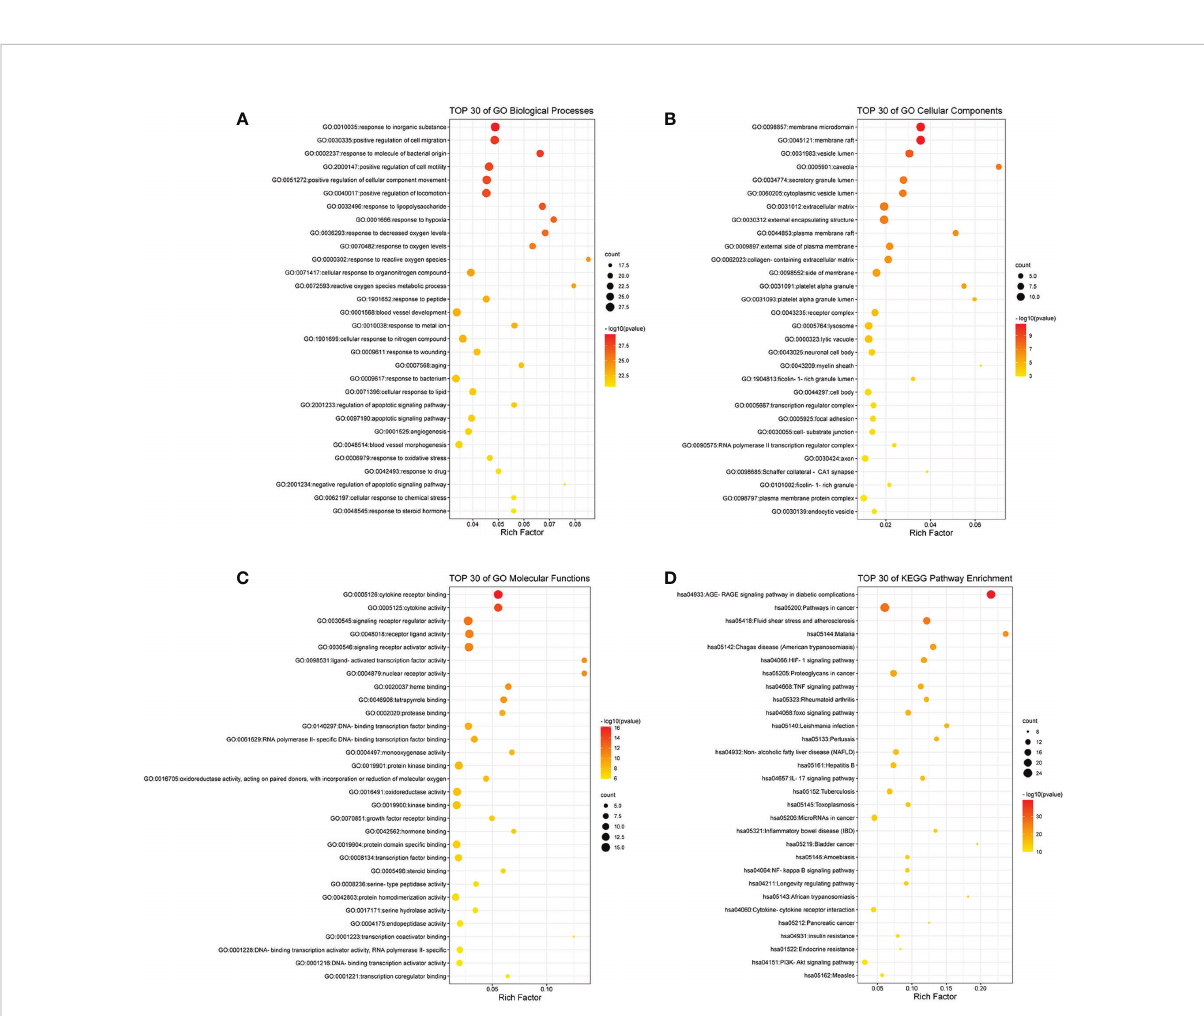
FIGURE 2 The bubble gram of the results of GO and KEGG pathway enrichment analyses. (A) The top 30 GO terms of biological processes. (B) The top 30 GO terms of cellular components. (C) The top 30 GO terms of molecular functions. (D) The top 30 KEGG enrichment pathways. All the GO terms and KEGG pathways with p -value <0.01 were considered to be statistically signi fi cant. GO, Gene Ontology; KEGG, Kyoto Encyclopedia of Genes and